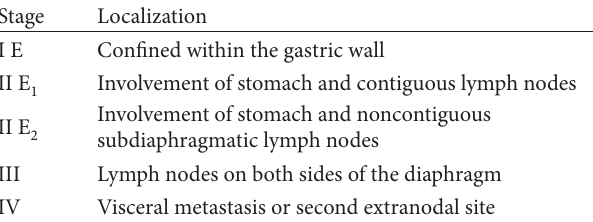
Table 1: Ann Arbour clinical staging for gastric